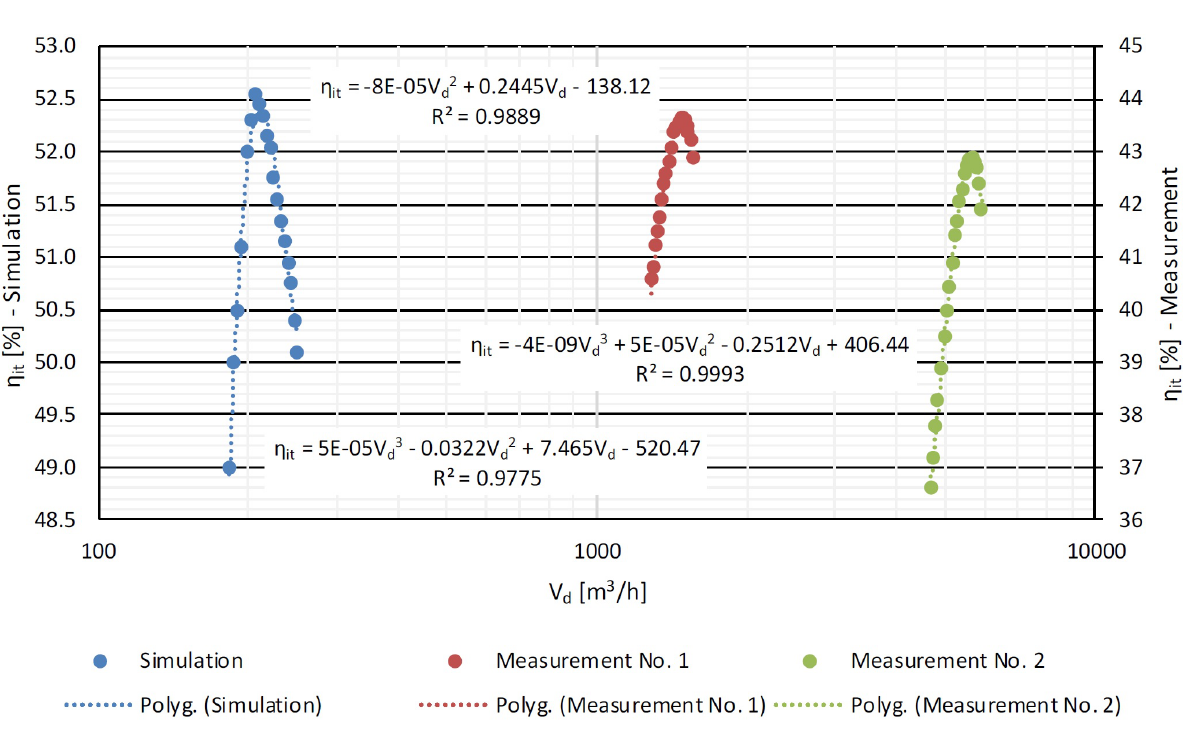
Figure B3: Eflciency